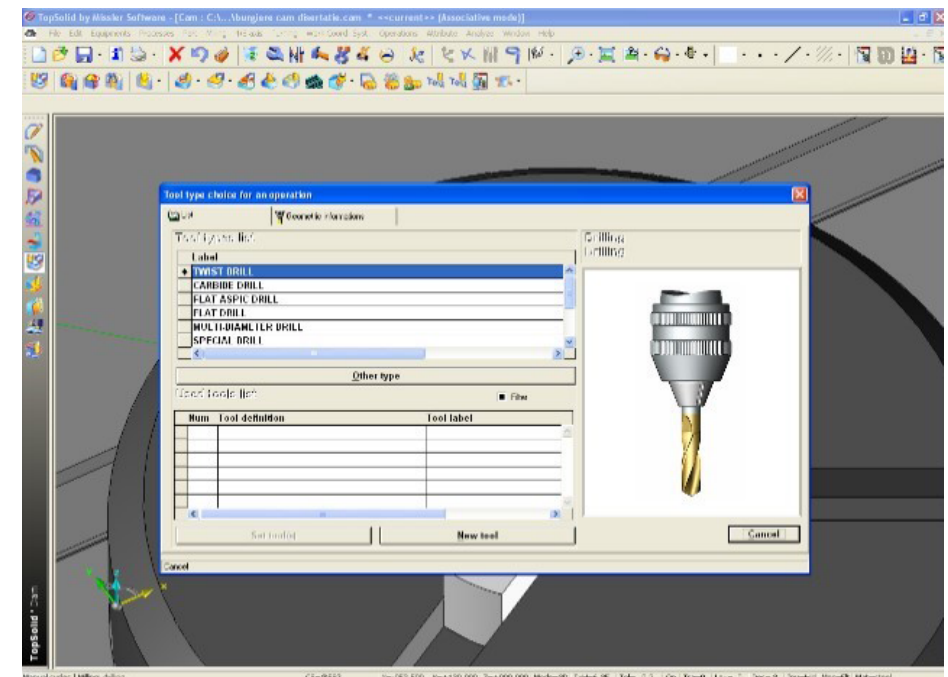
Figure 18. TopSolid CAM tool parameters.